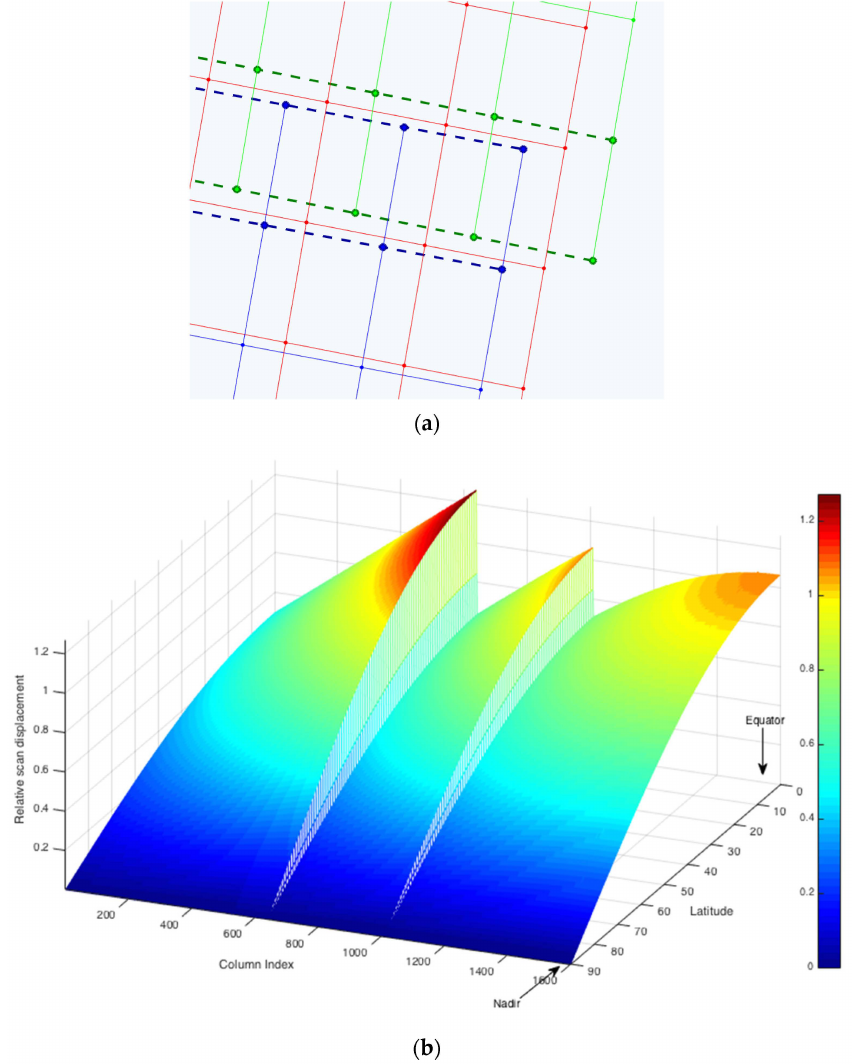
Figure 7. ( a ) The geo-locations of three consecutive VIIRS scans near the end of the swath are shown in green, red and blue. Portions of the scans corresponding to onboard deletions are marked by dashed line; ( b ) Relative scan displacement as a function of latitude and scan